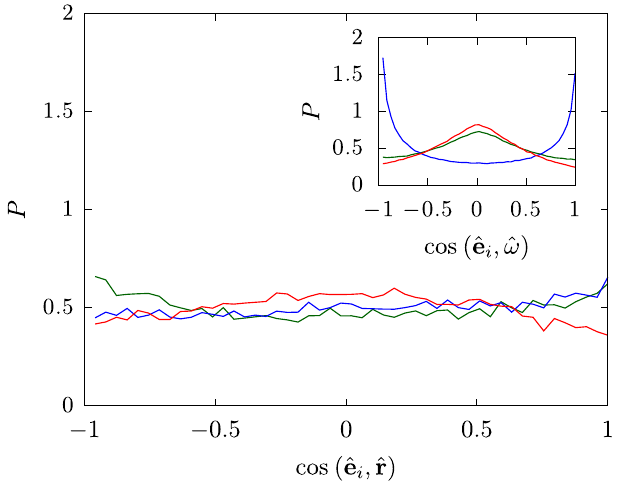
FIG. 12. PDF of the cosine of the angle between the strain-rate- tensor S eigenvectors ˆ e i , and the fiber orientation unit vector ˆ r ¼ r = j r j ; the eigenvectors ˆ e i are associated with the eigenvalue λ λ ≥ λ ≥ λ i , such that 1 2 3 (green, blue, and red lines, respec- tively). The inset shows the PDF of the cosine of the angle between the strain-rate-tensor eigenvectors and the vorticity direction. The fiber length is c= L ¼ 0 . 57 , while the scale Δ at which S is measured is Δ =L ¼ 0 . 86 . The turbulence is generated by rough wheels rotating at 400